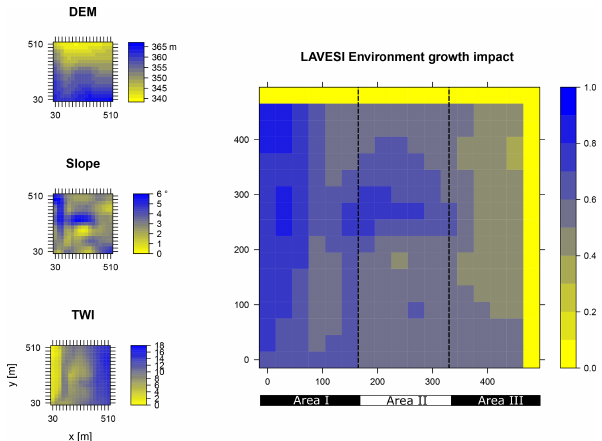
Figure B1. Elevation (DEM), slope angle, and terrain water index (TWI) define the environment growth impact (0 no growth possible; 1 good, no constraints) using an empirically fitted function for present forest growth at the area of interest Khamra.